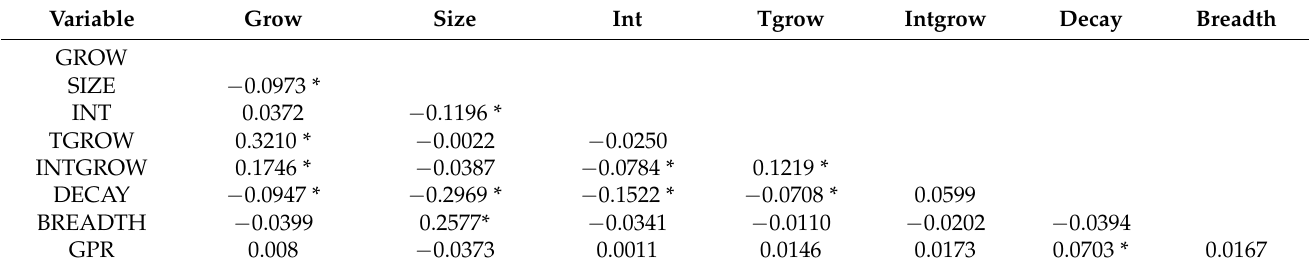
Table 6. Correlation